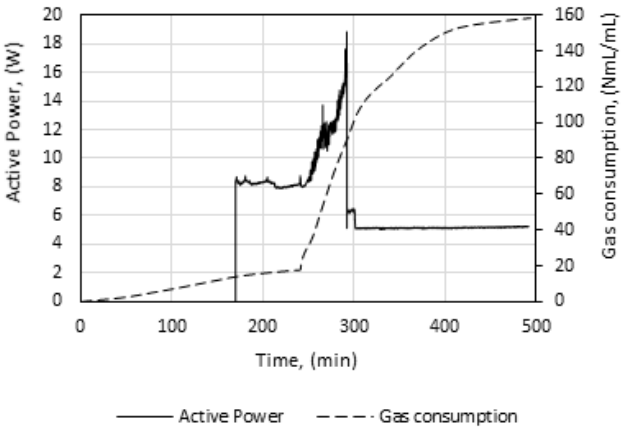
Figure 5. Power logging during a typical experimental run.